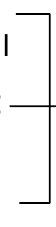
Figure 7. The fragment of polyvinyl chloride structure.